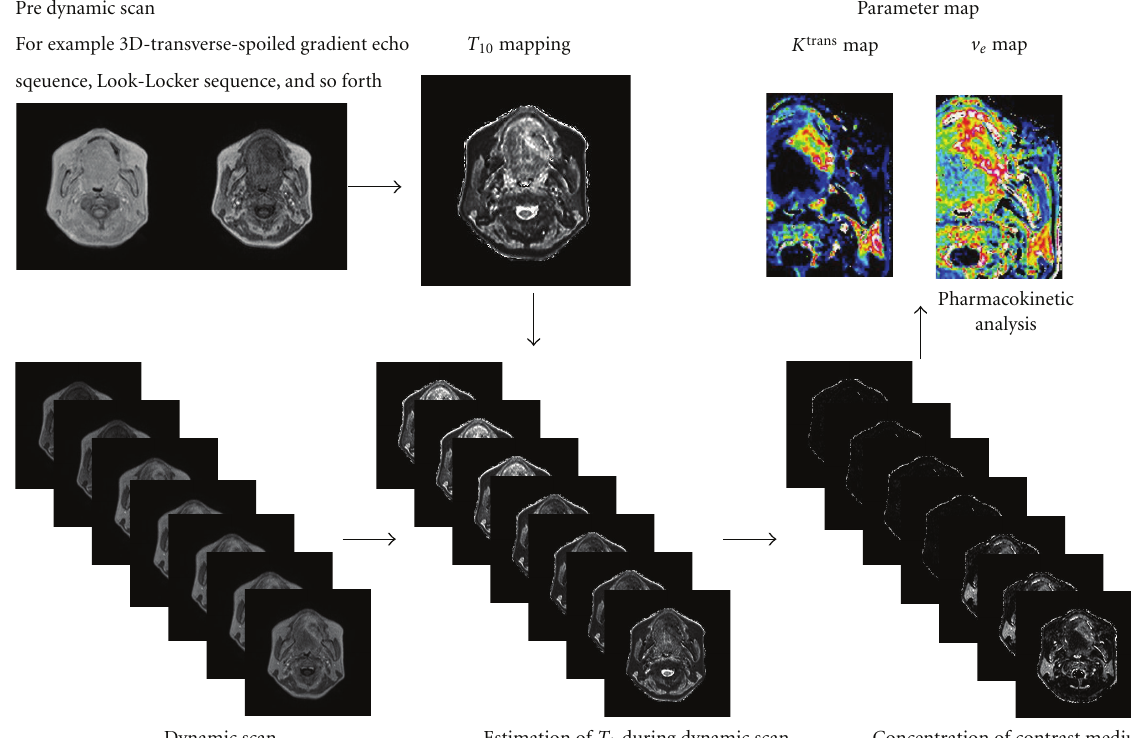
Pre dynamic scan